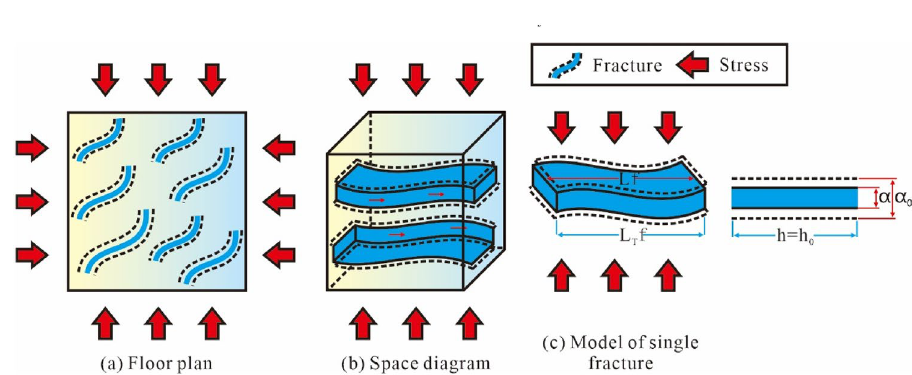
Fig. 5 Diagram of fracture stress sensitivity in the plate